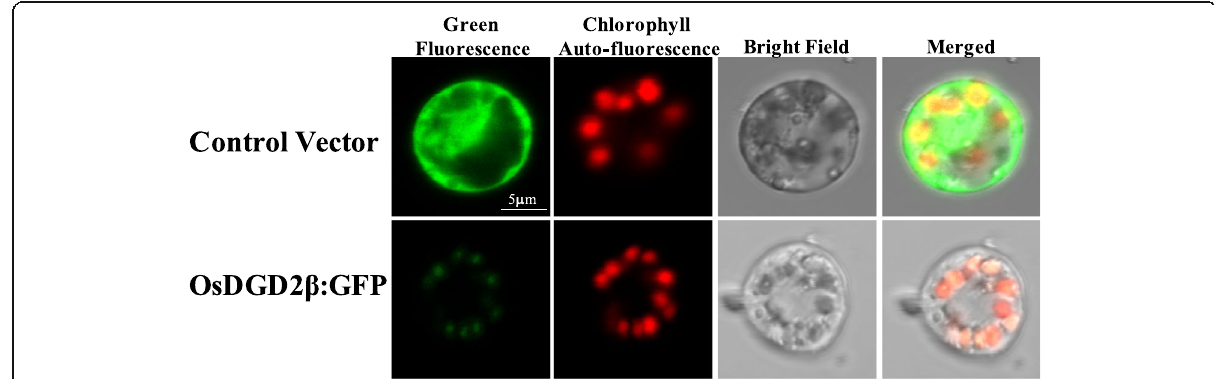
Fig. 2 Subcellular localization of OsDGD2 β via transient expression of 35S:OsDGD2 β :GFP in rice protoplast. Control vector (35S:GFP) has bright GFP signal distributed throughout the cell. 35S:OsDGD2 β :GFP has fluorescent signal localized in the chloroplast, confirmed by the red auto-fluorescent signal from chlorophyll